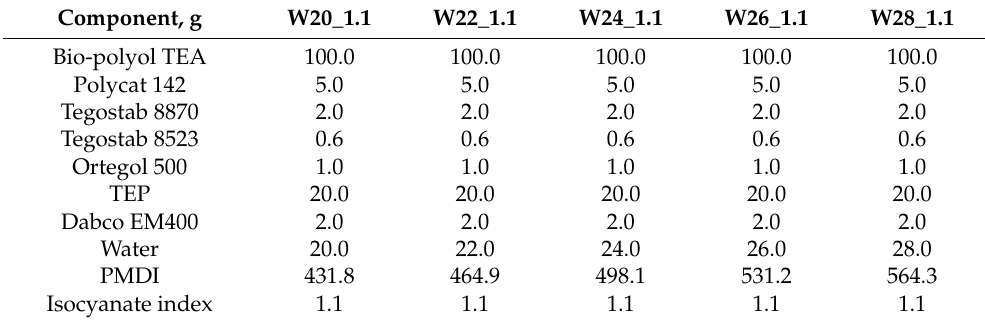
Table 1. The formulations of the foams with various water contents.